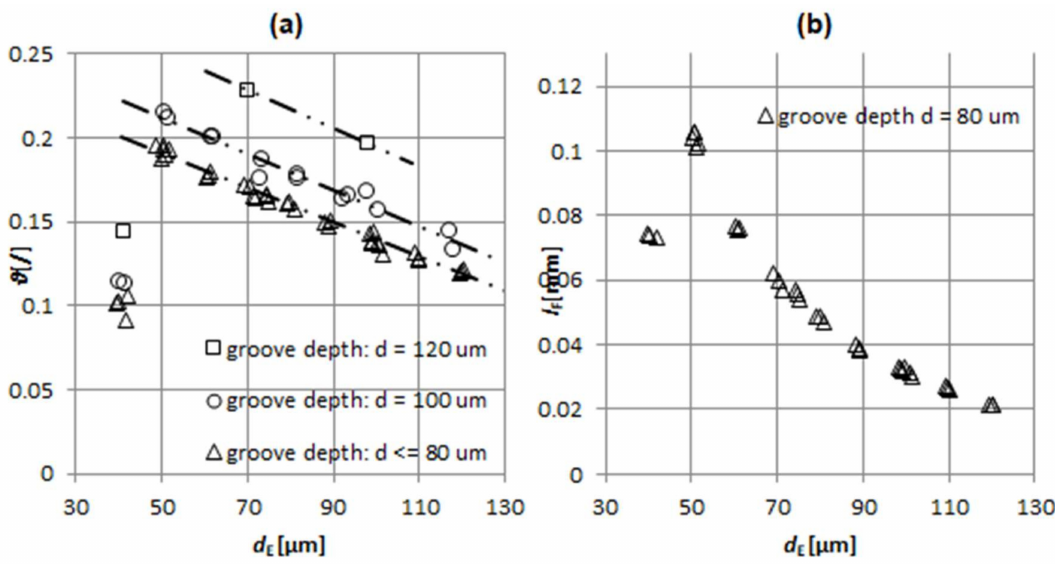
Figure 10. ( a ) Volumetric wear ratio ϑ with respect to electrode working diameter for grooves of di ff erent depths. ( b ) Linear wear l F with respect to electrode working diameter for groove depths of d = 80 µ